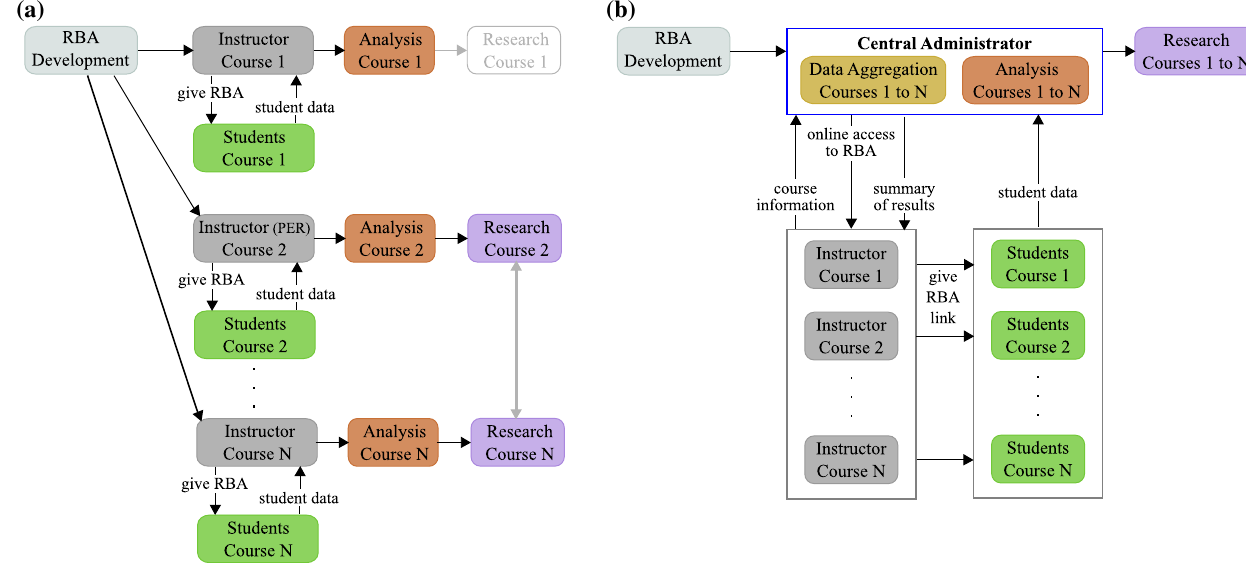
FIG. 1. (a) A schematic representation of the default model for the propagation of RBAs that has been used historically in PER. Here, light gray arrows denote rare or nonexistent connections. This model depends almost entirely on the instructor to drive the administration and analysis of their students ’ results. There is also little to no mechanism for data from multiple courses to be centrally aggregated or compared. (b) A schematic representation of an alternative, centralized model for the administration and analysis of RBAs. This model depends almost entirely on a centralized administration system to facilitate administration and analyze students ’ responses. This model also creates a centralized pool of comparison data that can be used for research and analysis